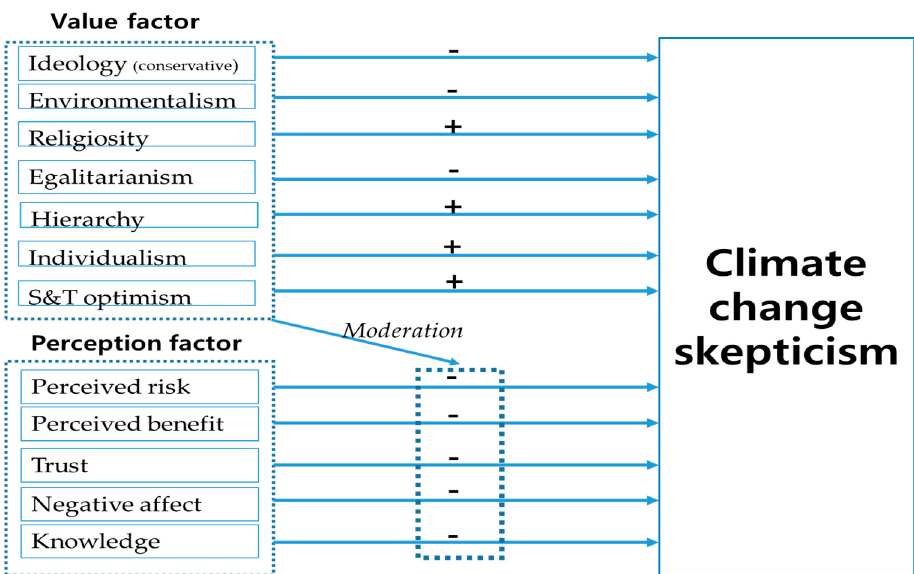
Figure 1. Research framework and hypotheses.